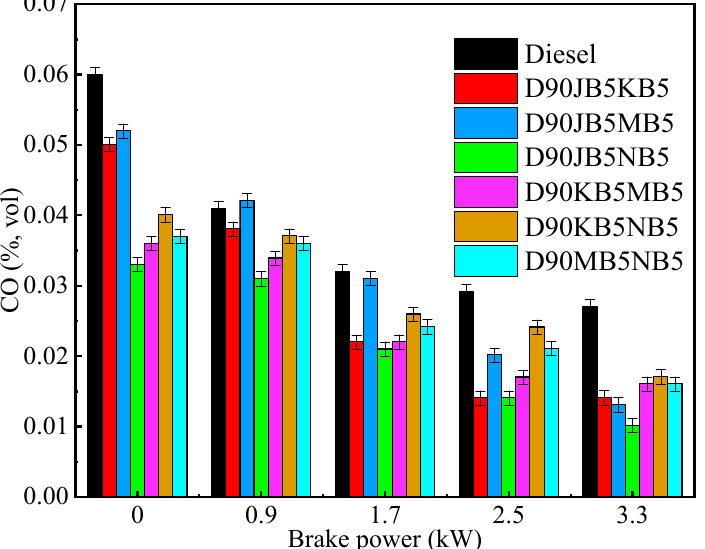
Figure 22. CO emission comparison of two biodiesel blends and diesel under different brake powers